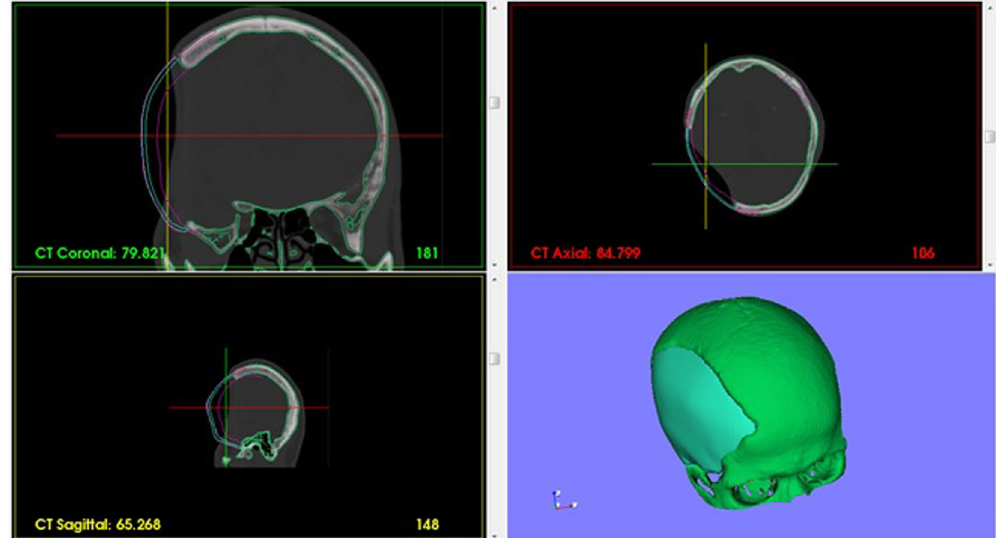
Figure 1. Evaluating one case of the cranial implant with the CT data of the patient.